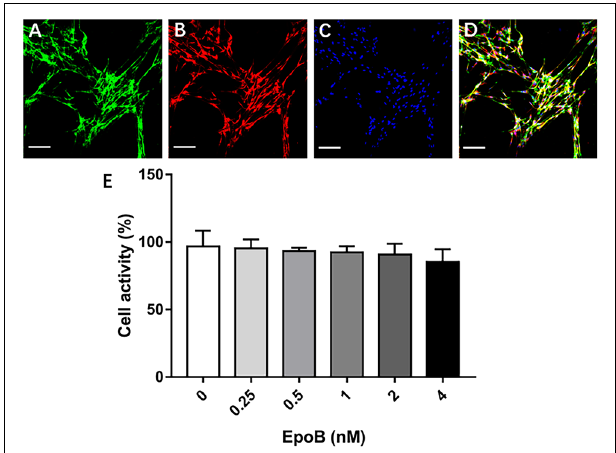
FIGURE 4 | Identification of SCs and measurement of their viability. Double-immunofluorescent staining of cultured SCs showing expression of p75 NTR (green; A ) and S-100 (red; B ) with DAPI nuclear counterstaining (blue; C ). (D) Merge images showed a SC purity > 96%. (E) Effects of EpoB on SC viability assessed by the CCK-8 assay. Scale bar: (A–D) 100 µ m. Abbreviations: EpoB, epothilone B; CCK-8, Cell Counting Kit 8; SC, Schwann cell; DAPI,